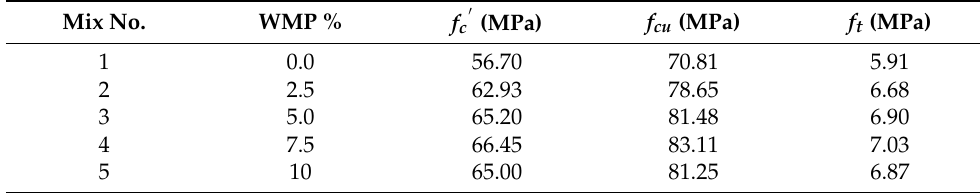
Table 5. Concrete mixes’ design